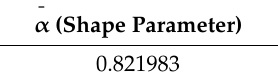
Table A13. MNIG Shape parameter α for Vector 4: Daqing, Marlim, SHCOMP, IBOV.